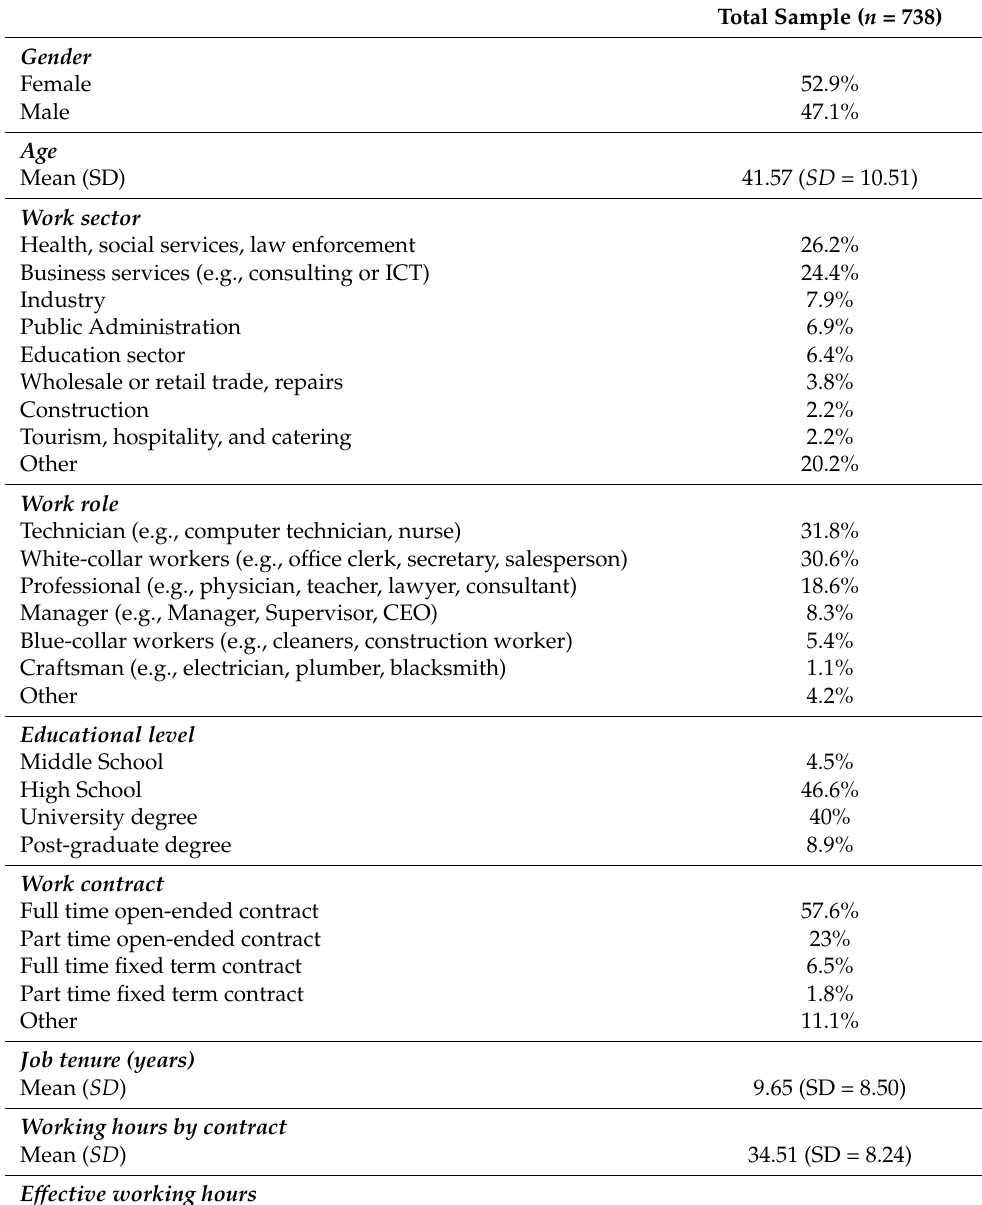
Table 1. Description of study